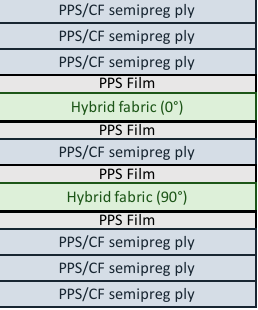
Table 2. Specification for low velocity impact